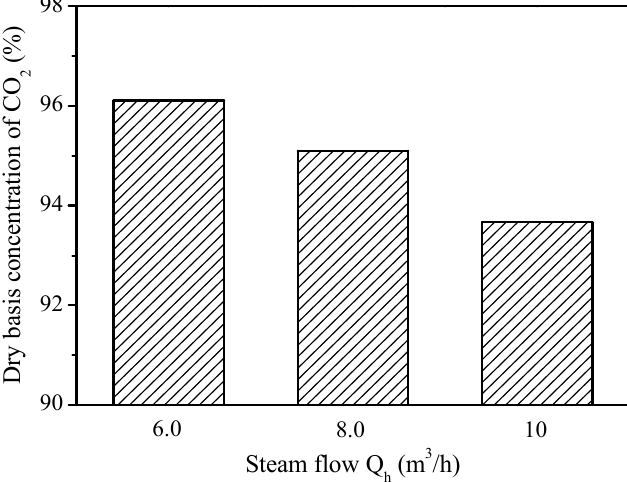
Figure 11. Effect of steam flow on the CO 2 concentration (dry basis) at the outlet of the fuel reactor.